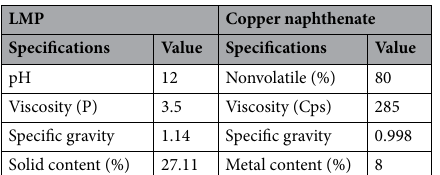
Table 1. The physical properties of low-molecule phenol (LMP) and copper naphthenate.